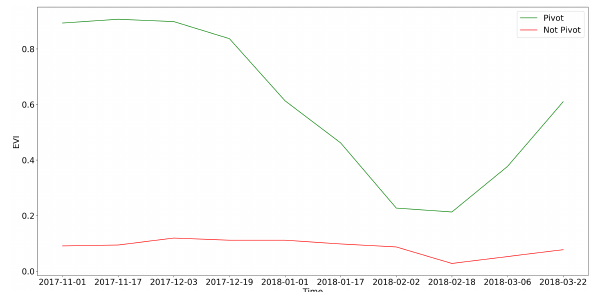
Figure 5. Example of time